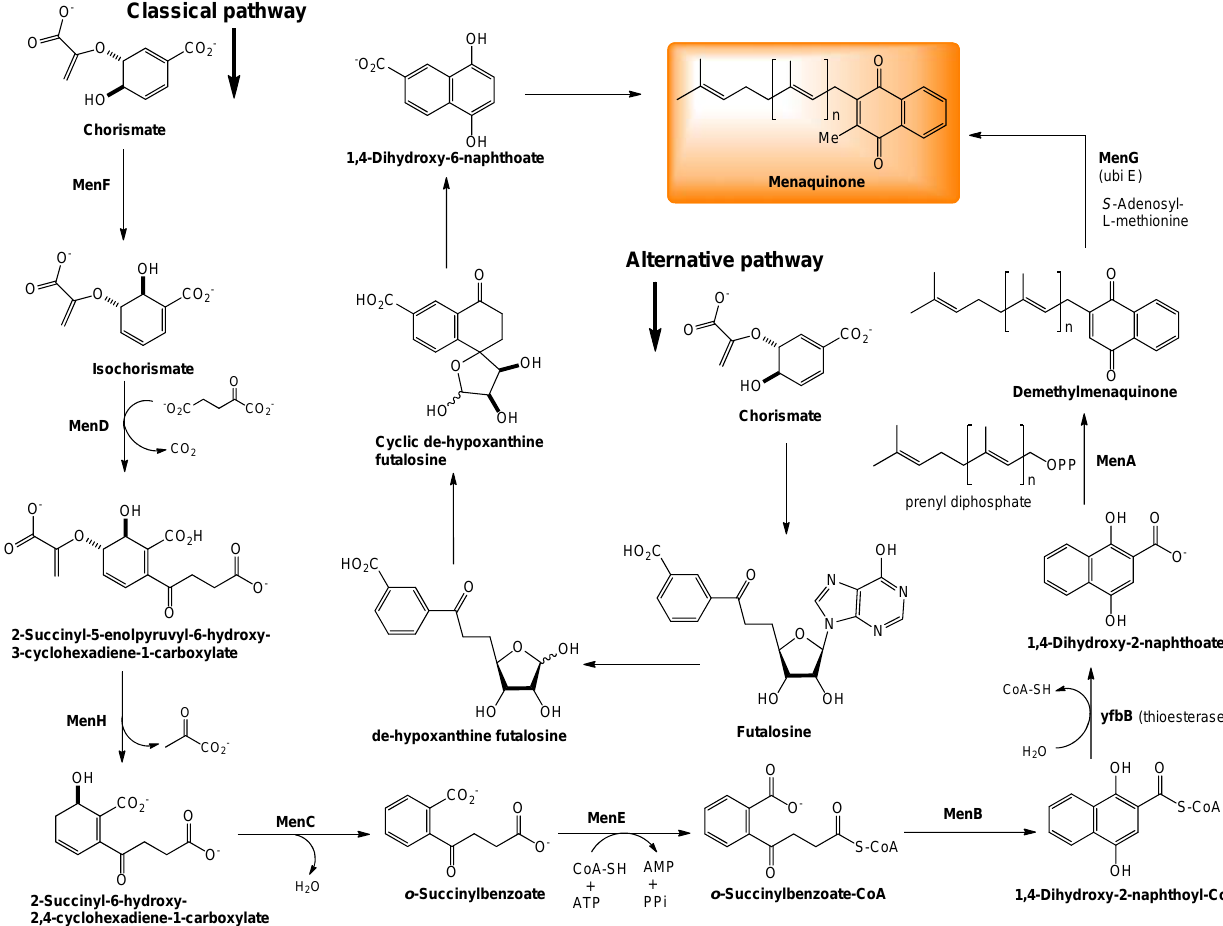
Figure 4. Biosynthesis of